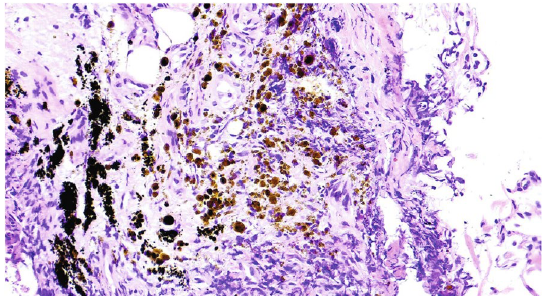
Fig. 3 Lung tissue with predominantly lymphocytic inflammatory infiltrate with hemosiderophages (200 micrometers, hematoxylin and eosin). Bronchial mucosa with ciliated columnar epithelial lining and, in the submucosa, moderate inflammatory infiltrate, predominantly lymphocytic in connective tissue with foci of anthracosis and